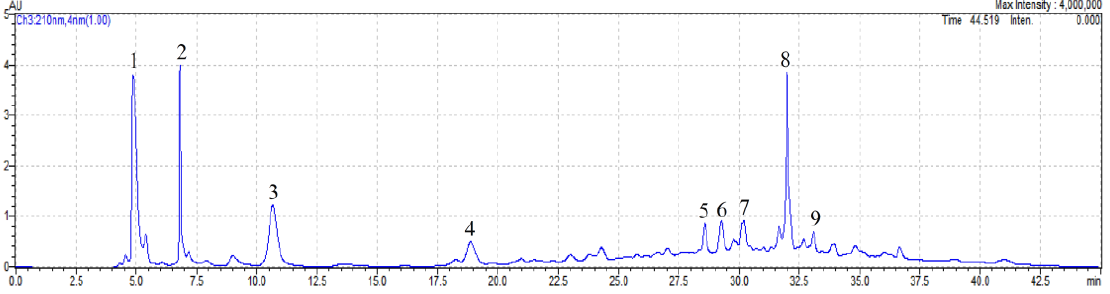
Figure 1. HPLC chromatogram of P. amarus methanol ( PA M) extract with PDA detector set at 210